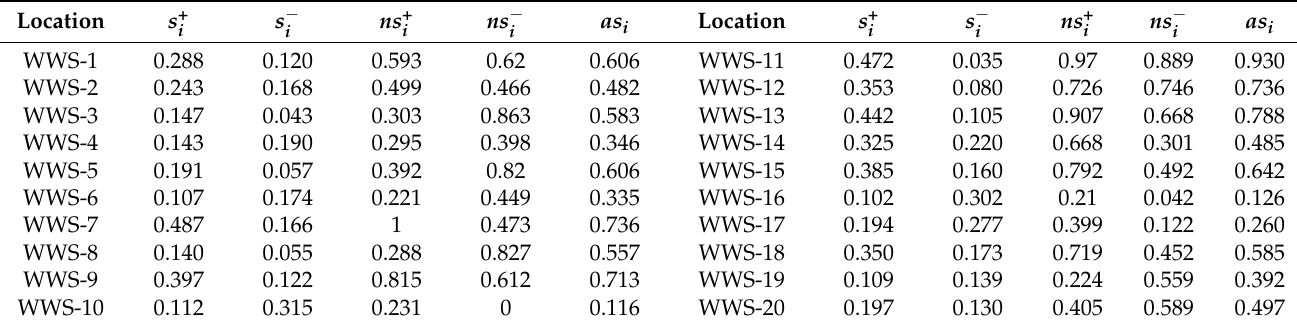
Figure 6. Evaluation criteria weight. Table 8. Spherical fuzzy EDAS